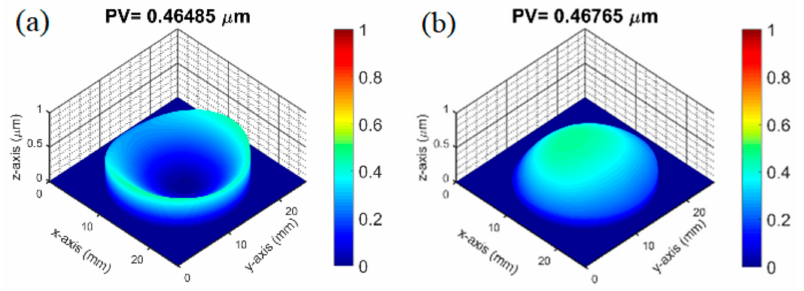
Figure 4. 3-D surface contour of the B270 substrate ( a ) before coating; ( b ) after coating.